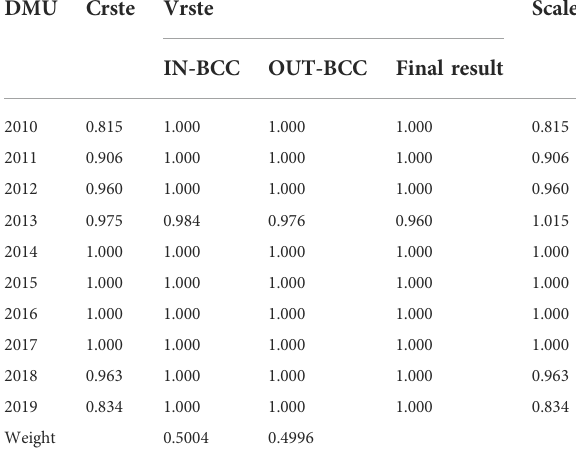
TABLE 6 Integration of investment and merger ef fi ciency evaluation results-National Grid. DMU Crste Vrste